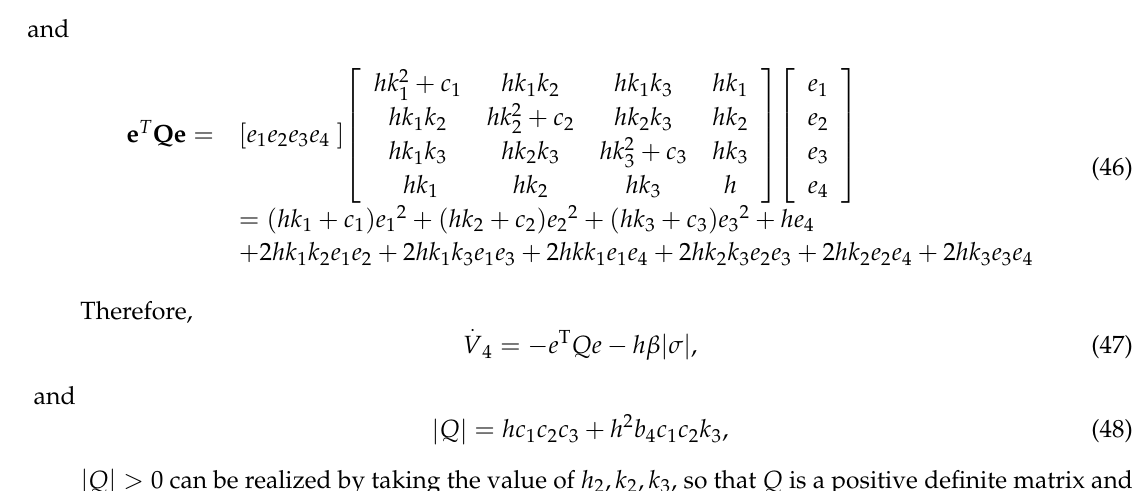
Figure 10. The delivery pressure of EHPAAPP with backstepping sliding control method in the case of input signal change from 28 MPa to 24 MPa with flow disturbance.